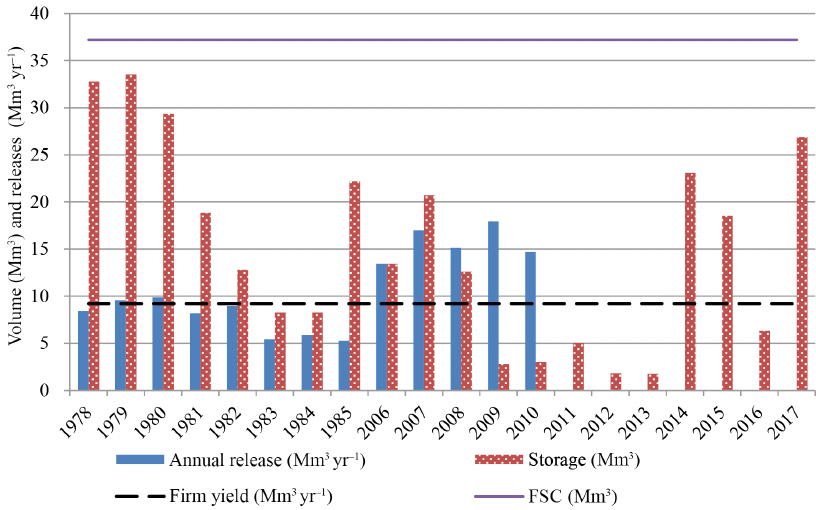
Figure 5. Storage levels in Mushandike Dam.